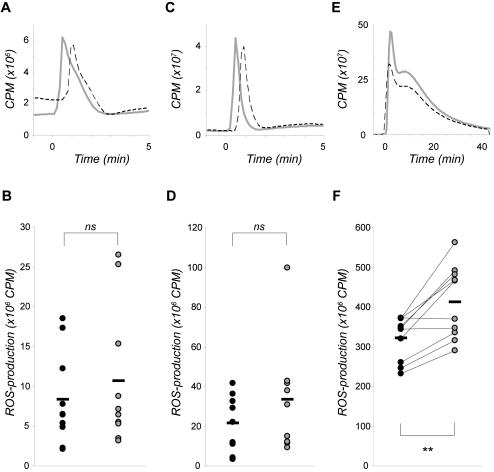
IL-8 and LTB4 induced ROS production in neutrophils from patients with stable CAD.The production of ROS in response to (A–B) IL-8 (100 ng/mL), (C–D) LTB4 (100 nM), or (E–F) PMA (50 nM), was measured in isolated neutrophils from patients (black dashed line and black dot, respectively) and individually matched controls (grey line and grey dot, respectively). Data are expressed as counts per min (cpm) and shown as one representative histogram plot (A,C,E) or as total ROS production peak value from 9–10 experiments per cohort (B,D,F). Mean value is indicated as a black hyphen. Wilcoxon signed-ranks test was used to determine significance between each patient and its individually matched control (** represents significant difference; p<0.01).